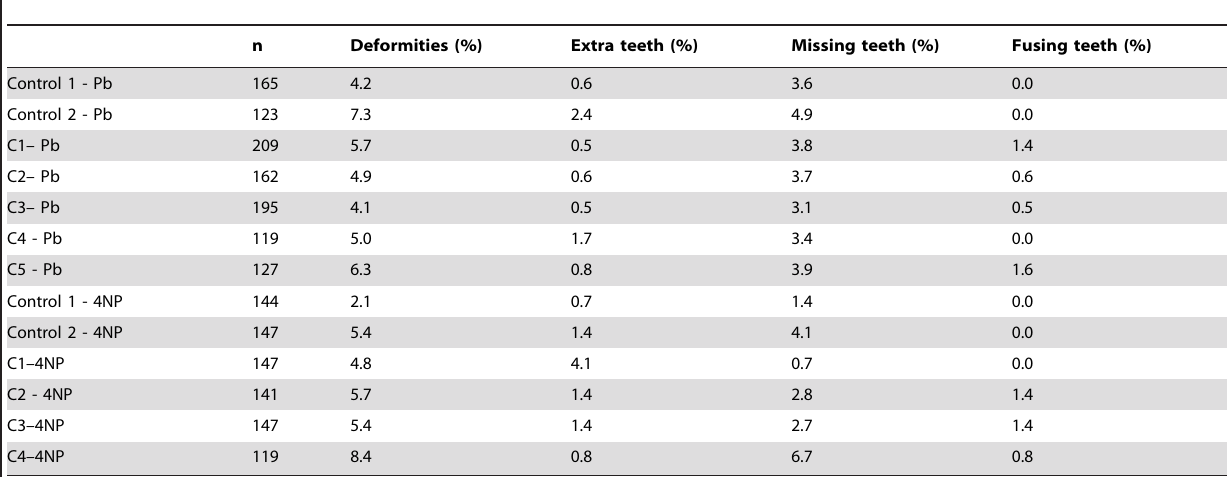
Table 2. Mean percentage of mentum deformities and proportion of each type of deformities.